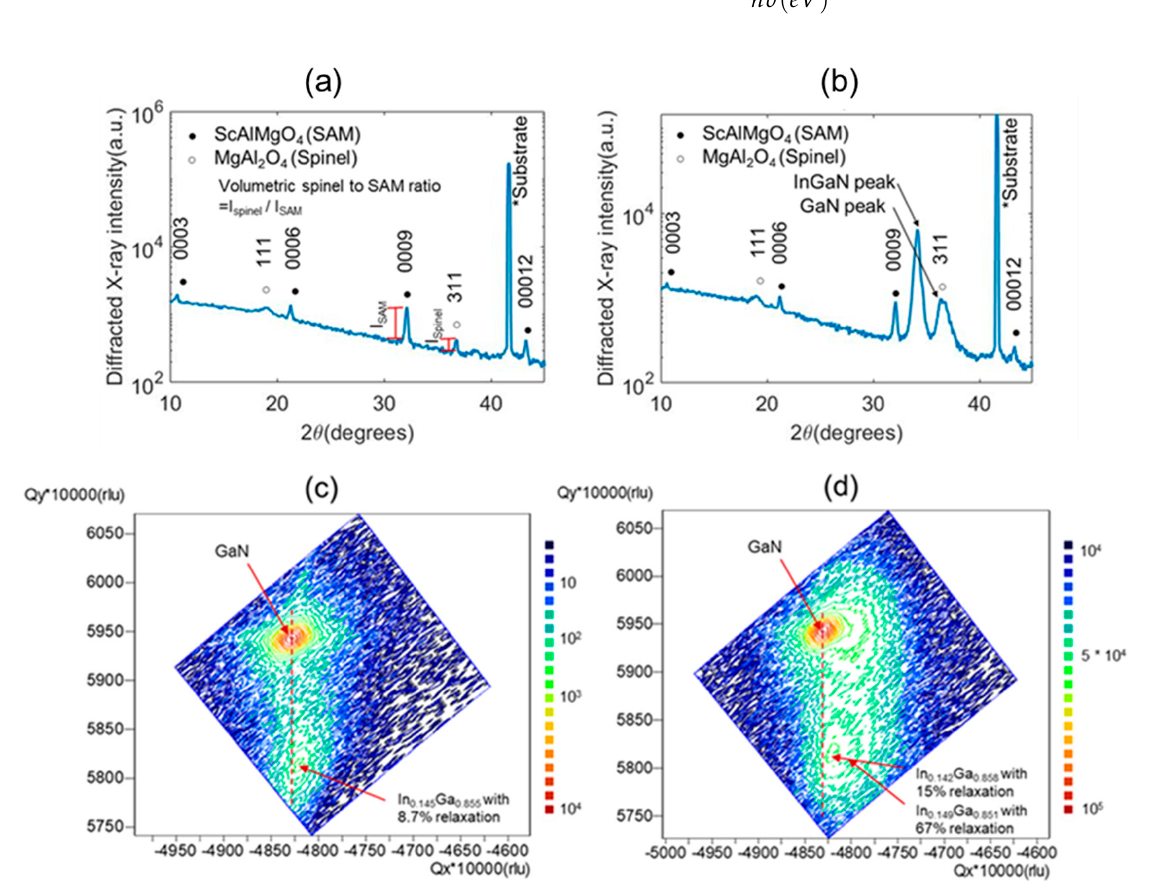
Figure 3. → XRD ω –2 θ of ( a ) Sample H, ( b ) Sample H with 100 nm InGaN on 75 nm SAM layer on Al 2 O 3 ; RSM ( − 1 − 1 4) of ( c ) 100 nm InGaN on GaN template; RSM ( − 1 − 1 4) of ( d ) 400 nm InGaN on GaN template.